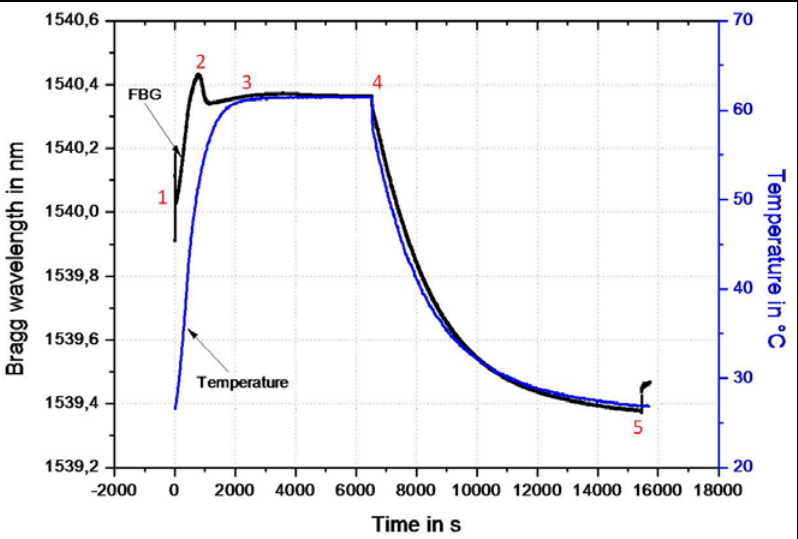
Figure 3. Cure cycling of a patch monitored with embedded FBG